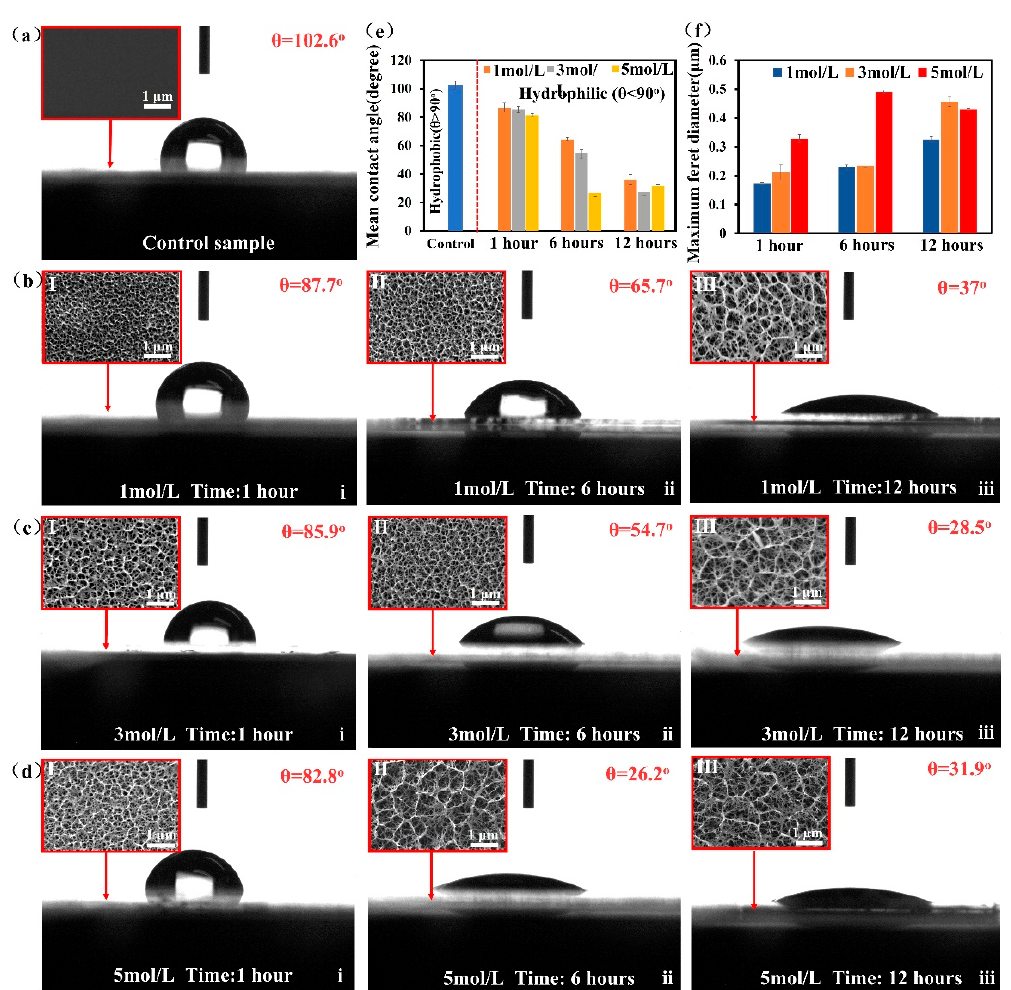
Figure 2. Surface wettability of the Ni/Ti samples: ( a ) WCA and SEM images of control sample; ( b ) WCA and SEM images of NTS modified with 1 mol/L of NaOH for 1, 6 and 12 h; ( c ) WCA and SEM images of NTS modified with 3 mol/L of NaOH for 1, 6 and 12 h; ( d ) WCA and SEM images of NTS modified with 5 mol/L NaOH for 1, 6 and 12 h; ( e ) Mean WCA vs. reaction time with various NaOH concentrations (n = 3); ( f ) Mean ferret diameter vs. reaction time with various NaOH concentrations (n = 3). Error bars indicate